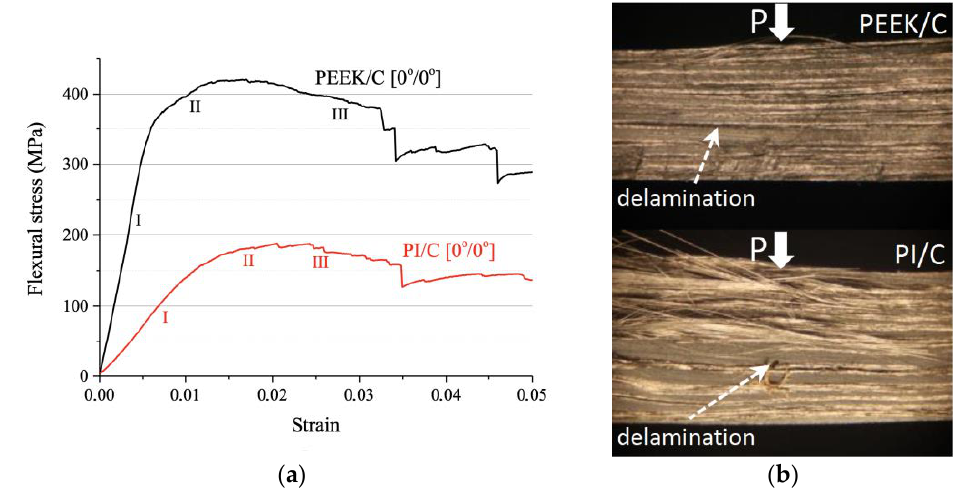
Figure 3. The flexural stress–strain curves ( a ) and optical images of the specimen cross-sections after the three-point flexural tests ( b ) for the PEEK/CF (0°/0°) and PI/CF (0°/0°)